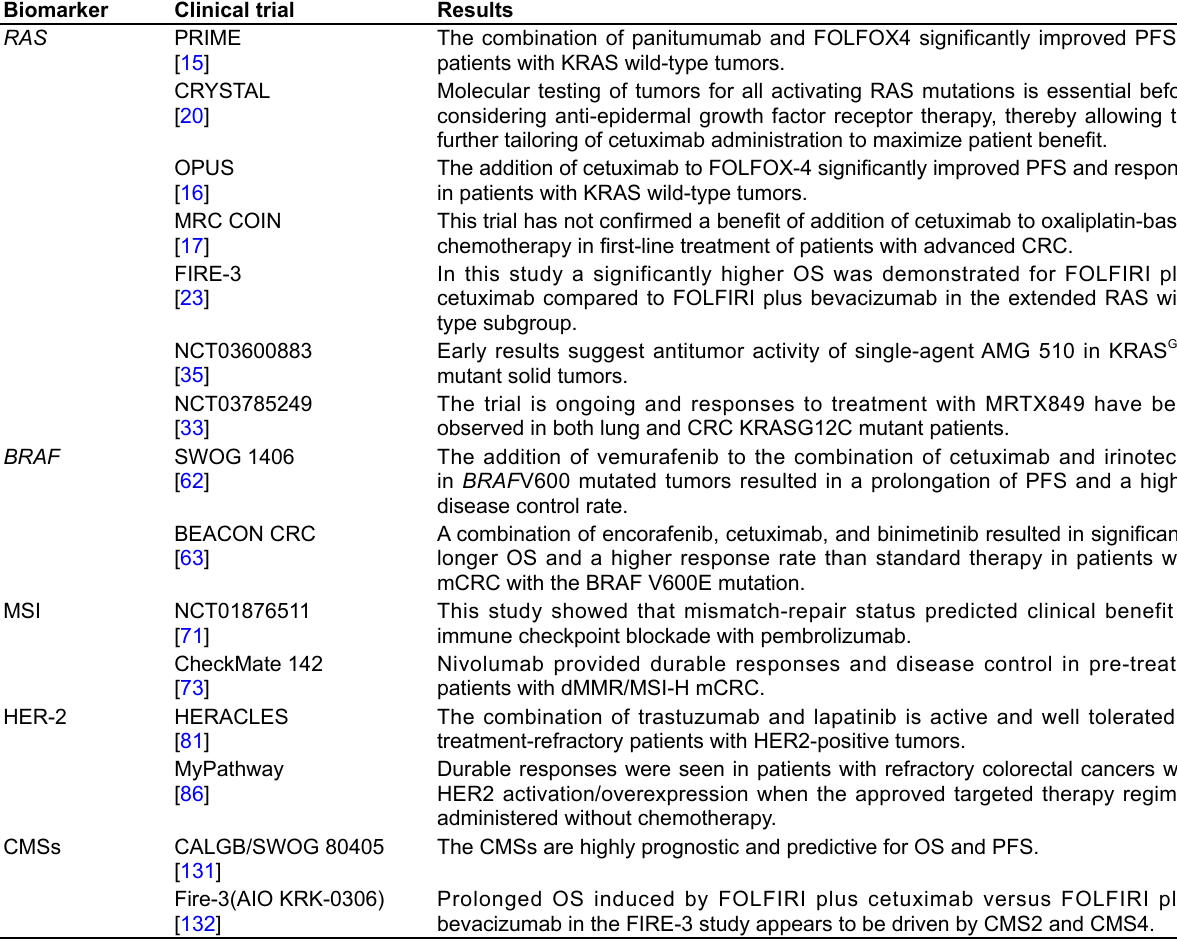
Table 2. Main clinical trials that explored predictive biomarkers in CRC Biomarker Clinical trial